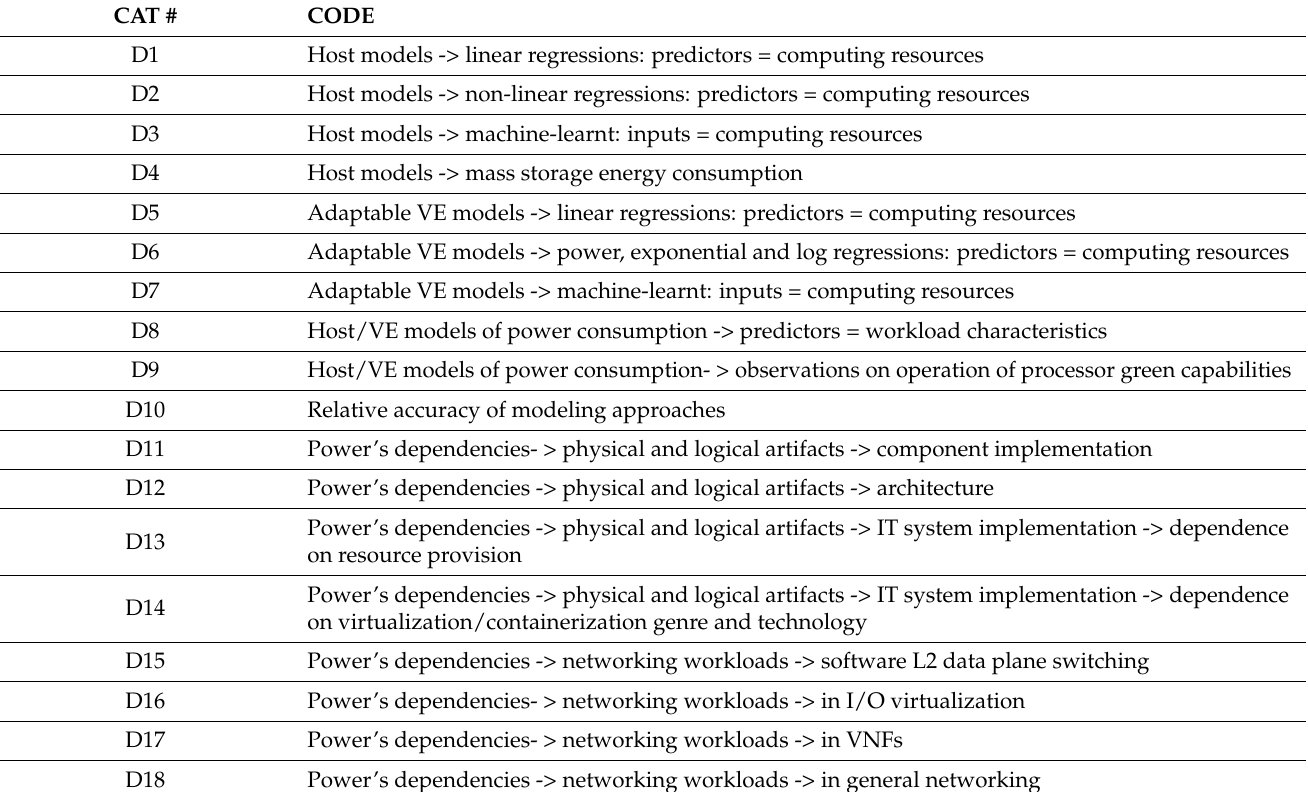
Table 4. Development category